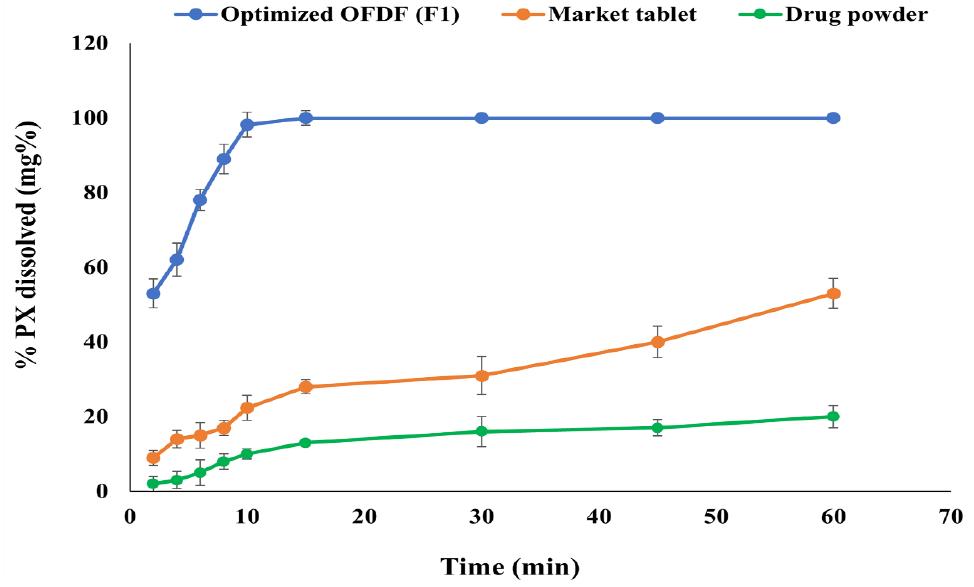
Figure 5. Dissolution profiles of the optimized OFDF loaded with PX nanosuspension (F1), PX pure powder, and the market tablet.